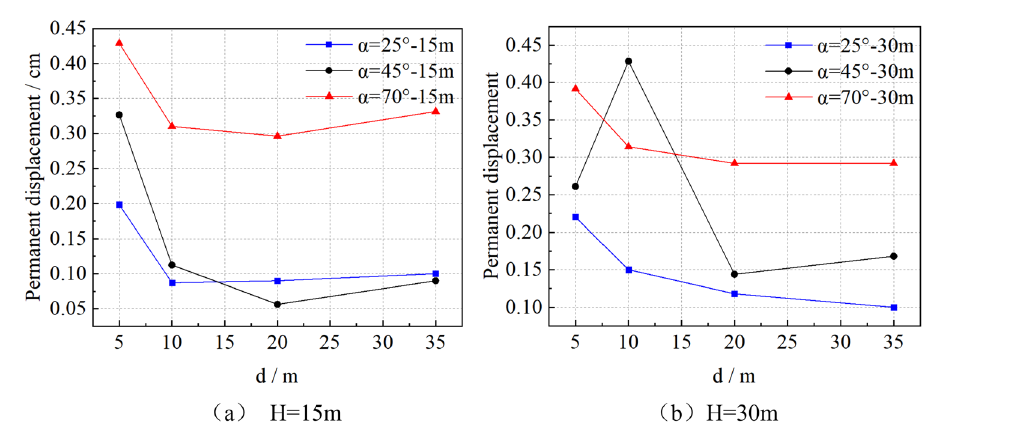
Figure 9. Variation curve of permanent displacement of top building with distance of d